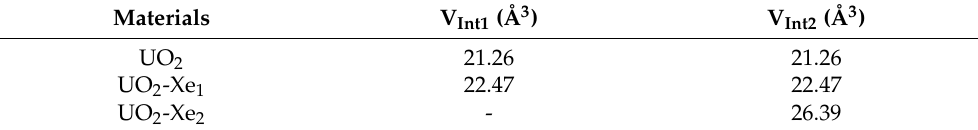
Table 6. Cluster behavior of Xe atoms in pure UO 2 results in a volume change of interstitial sites.